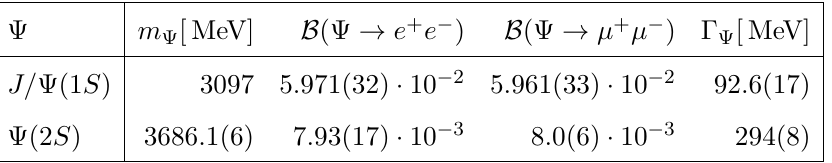
Table 2 . Data of charmonium resonances included in our analysis as taken from [31]. The J/ Ψ mass uncertainty is negligibly